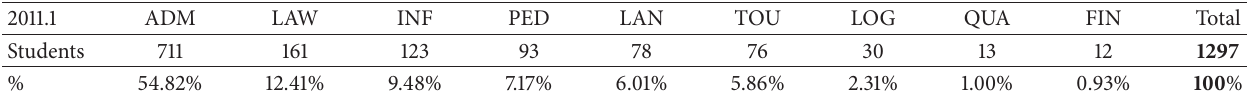
Table 1: Student